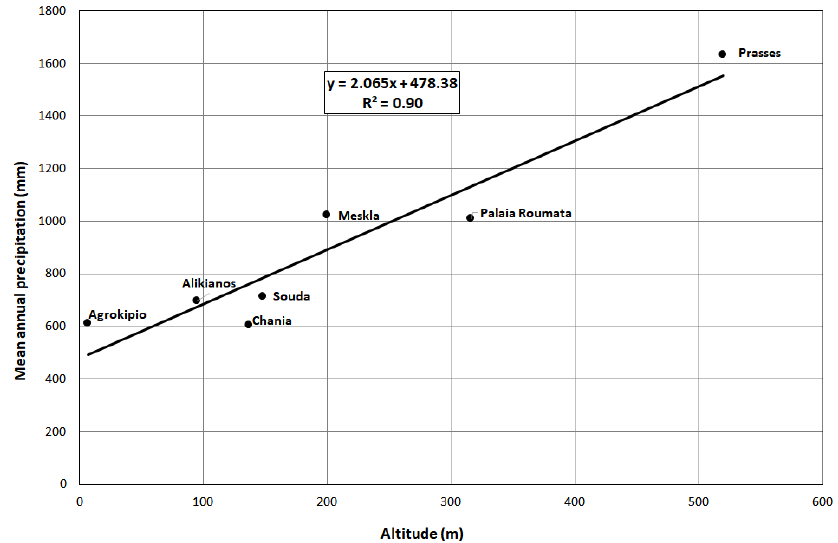
Figure 3. Relationship between the rainfall and the latitudes of the rain gauge stations.